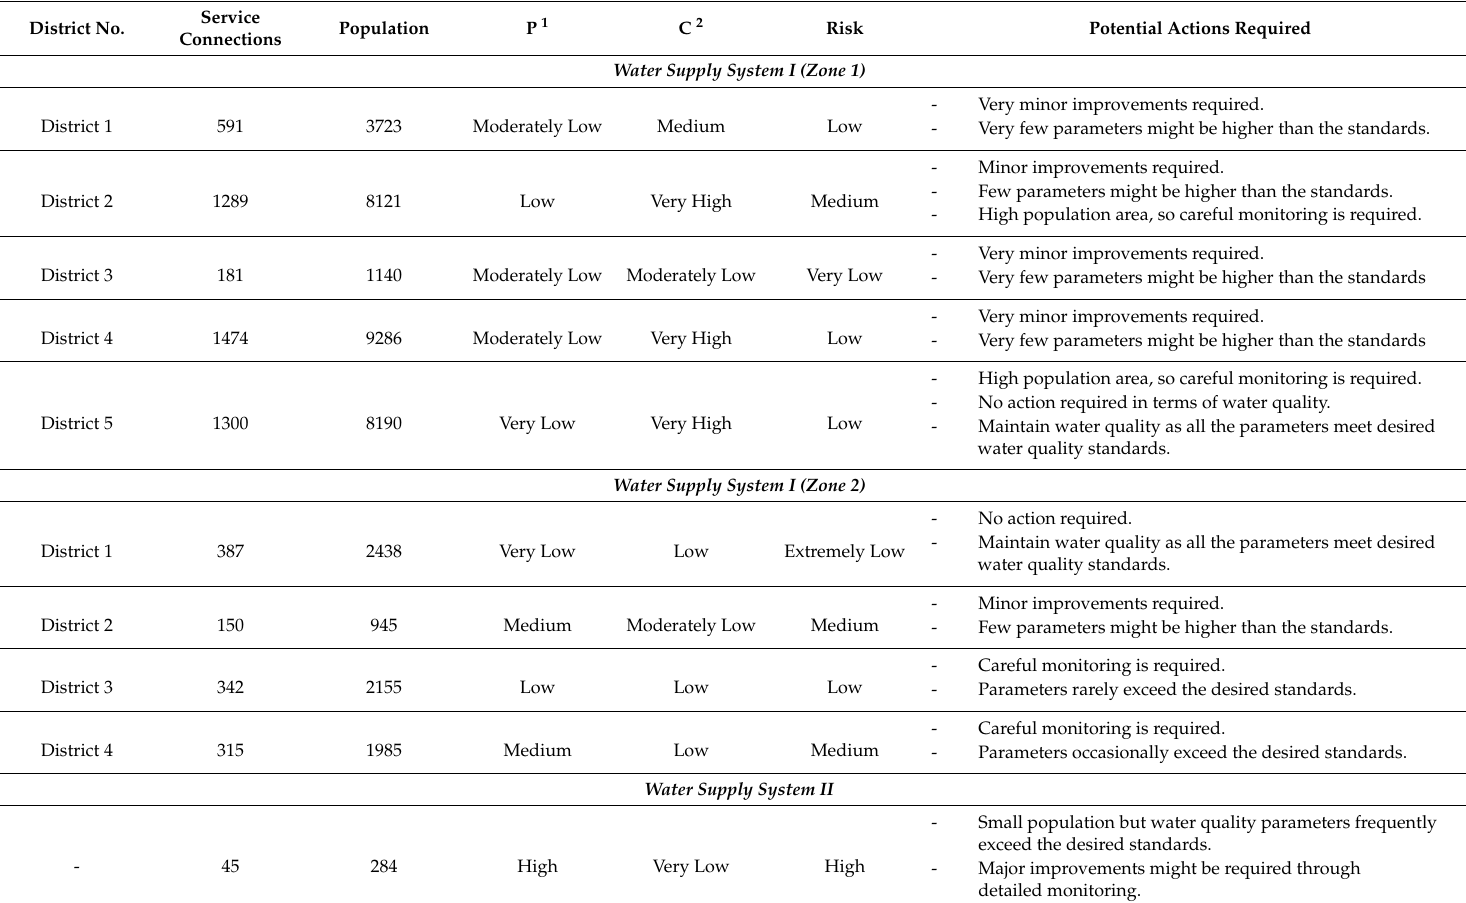
Table 6. Population statistics in water supply systems of the study